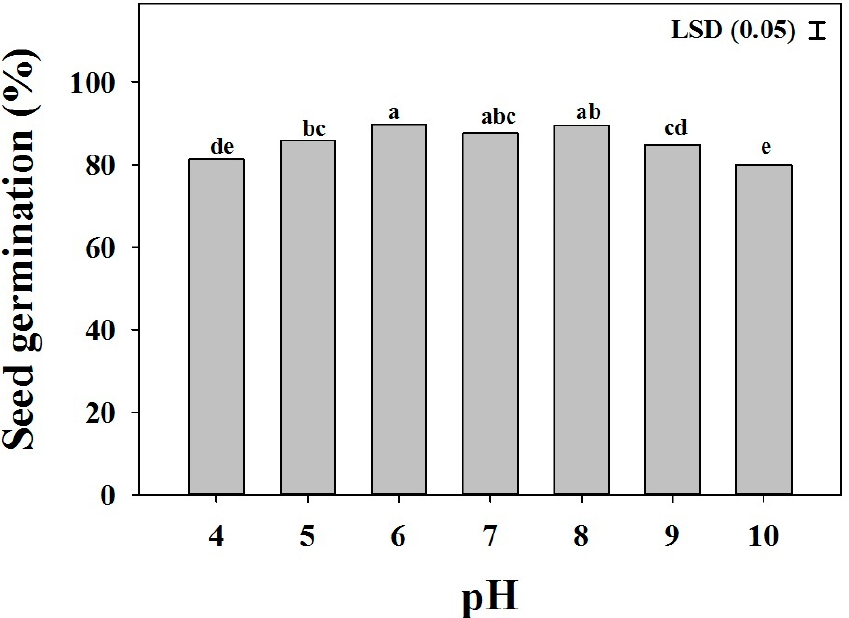
Figure 5. The effect of sodium chloride (NaCl) concentrations on the seed germination of three biotypes of B. eruciformis . Each point of the graph represents a mean value of the germination data (pooled across biotypes), as no significant differences were observed among biotypes. A three- parameter logistic model was fitted to the germination (%). The vertical bars represented the standard error of mean.